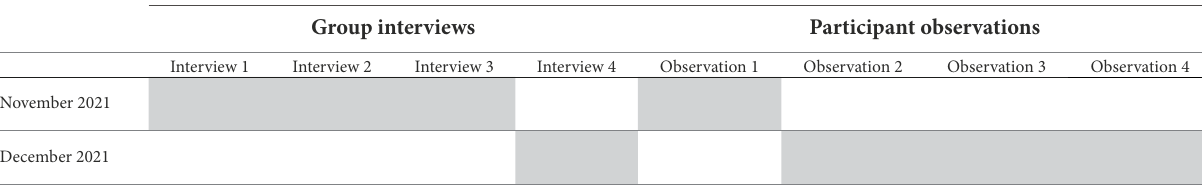
TABLE 4 Data collection